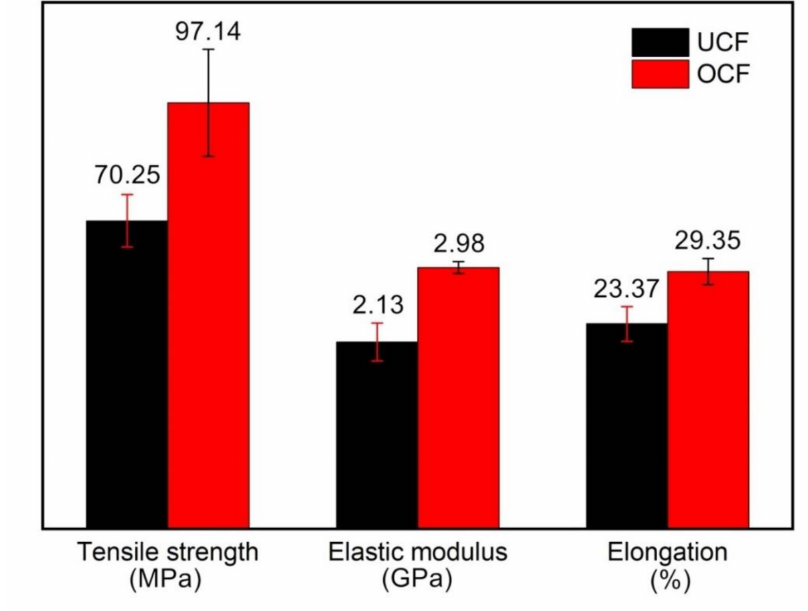
Figure 9. Mechanical properties of untreated and treated coir fibers under optimal conditions.